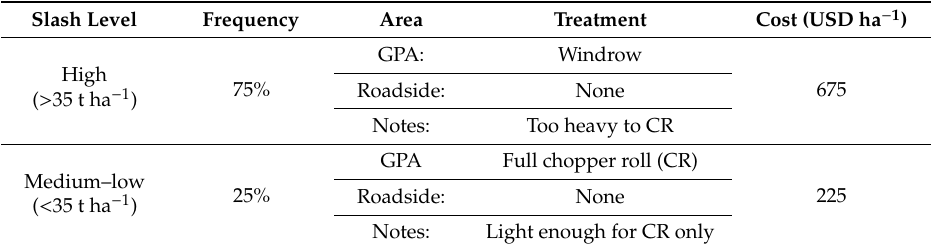
Table 3. Site preparation procedures and costs for the CTL